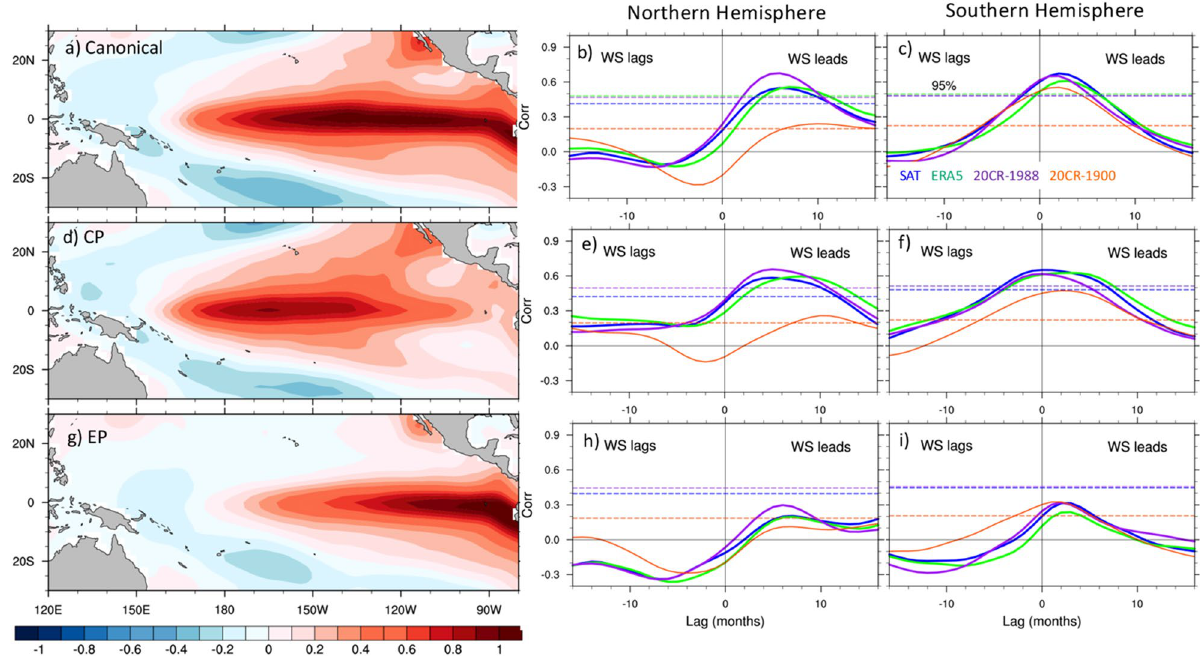
Figure 3. Flavors of El Niño diversity and their relationship with wind speed variability. ( a ) SST pattern associated with the leading PC of SST in the tropical Pacific (10° S–10° N), representing a “canonical” ENSO pattern. ( d ) and ( g ) CP and EP El Niño patterns obtained by regressing the SST field on the CP and EP indices (Eq. 2), respectively. The right two columns show the lag-correlations of the “canonical” ( b , c ), CP ( e , f ), and EP ( h , i ) indices with the Northern Hemisphere (middle column) and Southern Hemisphere (right column) wind speed PCs for satellite winds (blue), ERA5 (green), 20CR-1988 (purple), and 20CR-1900 (orange). Positive lags indicate that the wind speed PCs lead the ENSO indices. Horizontal dashed lines indicate the level of 95% statistical significance for the different products. The latter have been computed using the effective number